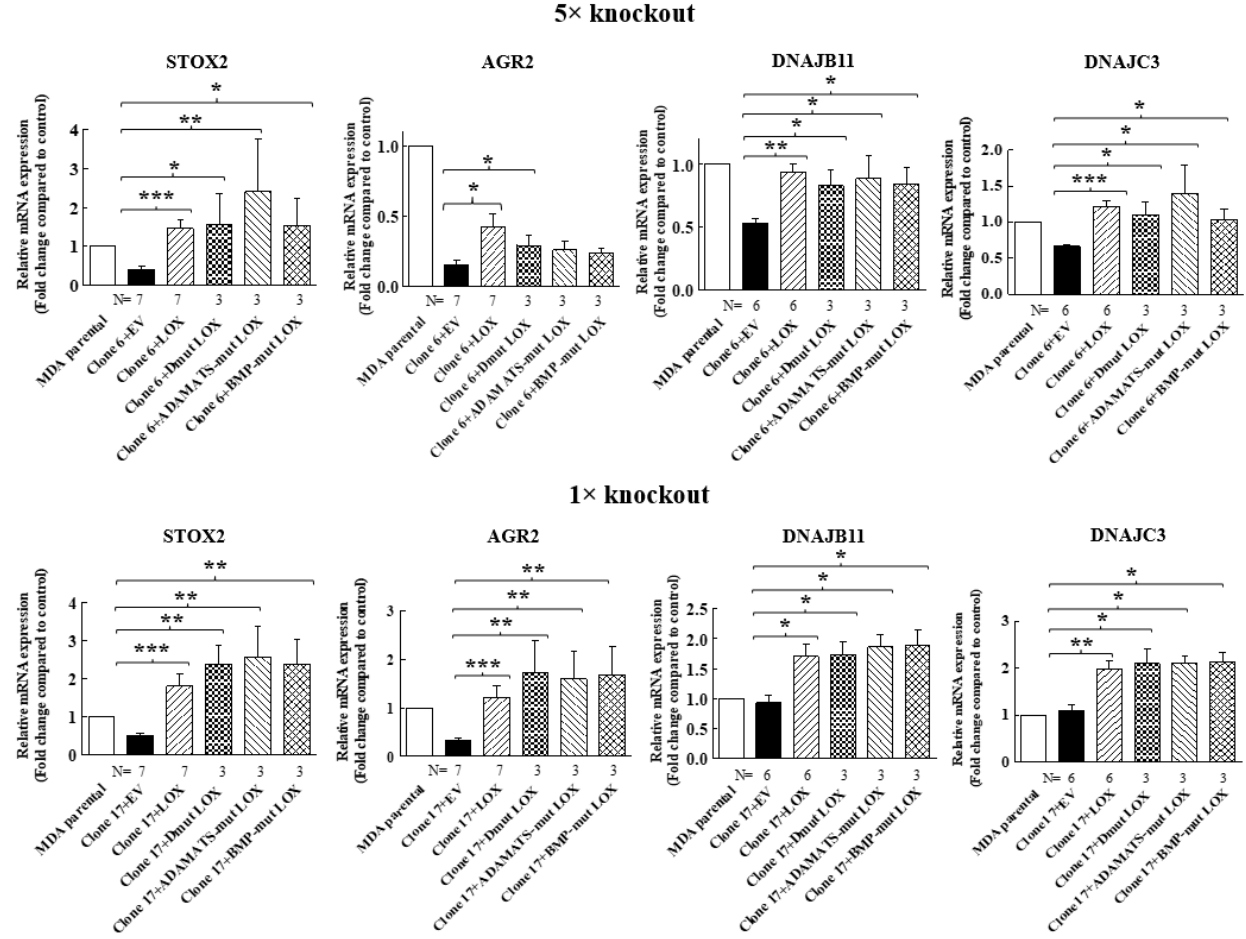
Figure 7. Point-mutated LOX variants that fail to be cleaved are still able to promote the expression of LOX-regulated genes. The expression levels of the STOX2, AGR2, DNAJB11 and DNAJC3 mRNA were determined in MB-MDA-231 as well as in 5 × and 1 × knock-out cells using qRT-PCR. The expression was compared with the expression level of these genes following the expression of the indicated LOX variants. Results were normalized with the expression level in MB-MDA-231 parental cells. Data represent the mean ± SEM of N independent experiments. Statistical significance was evaluated using the Mann–Whitney test. * p < 0.05, ** p < 0.01, *** p <